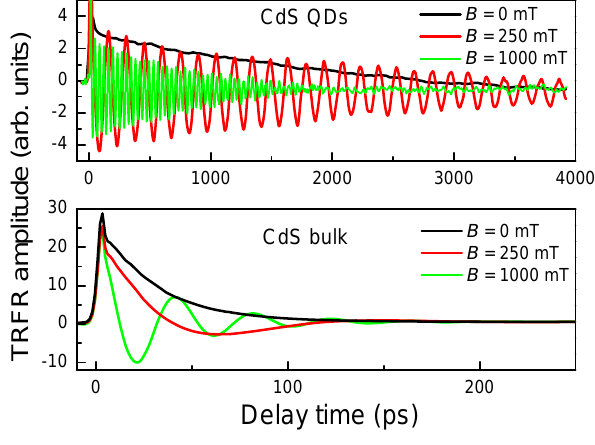
Figure 3. Time-resolved Faraday rotation signals for CdS QD and bulk sample in different transverse magnetic